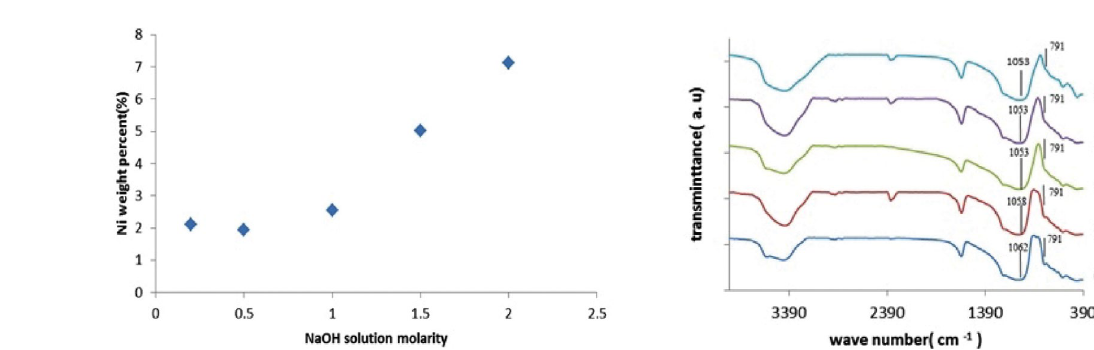
Fig. 4. FTIR spectra of the CLP, CLP-Ni, D05, D1.5 and D2.0